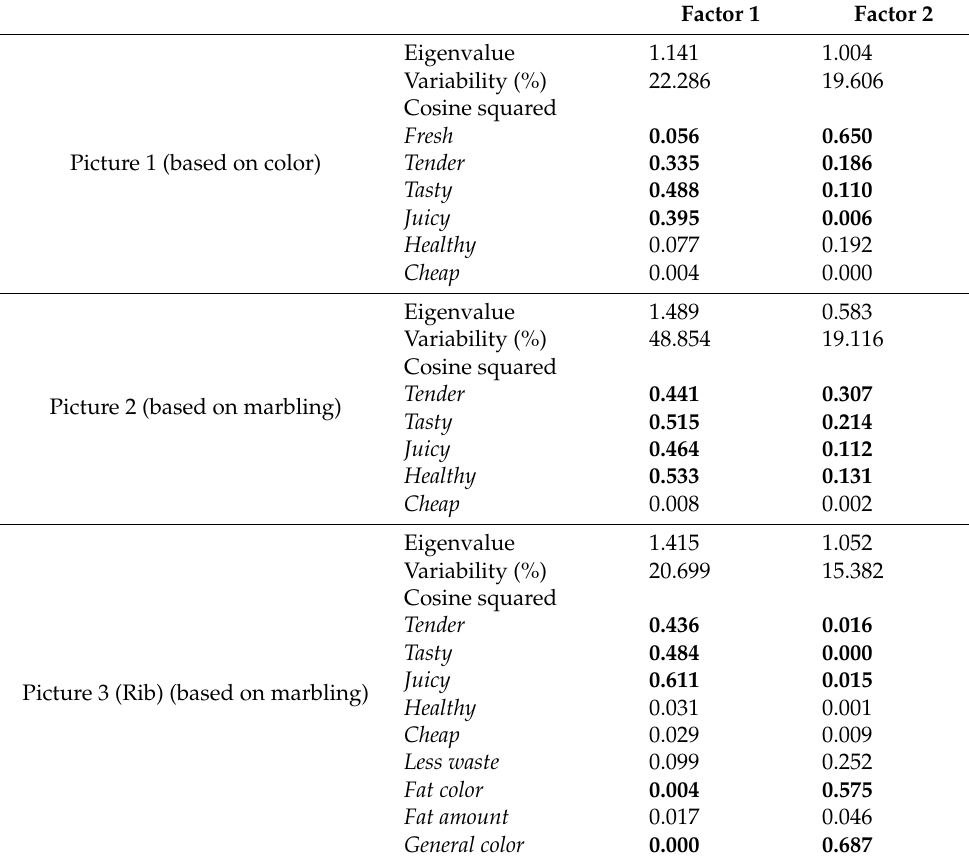
Table 6. Eigenvalue and percentage of variability explained by the first two factors for each of the three Multiple Factor Analysis carried out, and cosine squared for each variable in each factor. The criterion “none of the above” was excluded from the analysis. When the sum of the cosine squared in the two factors was >0.4, the criterion was chosen for the hierarchical cluster (values in bold). Factor